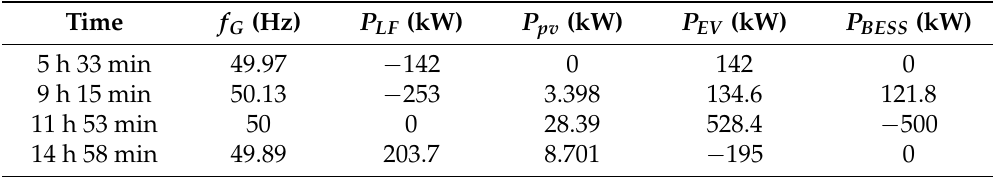
Table 3. Data points as shown in Figure